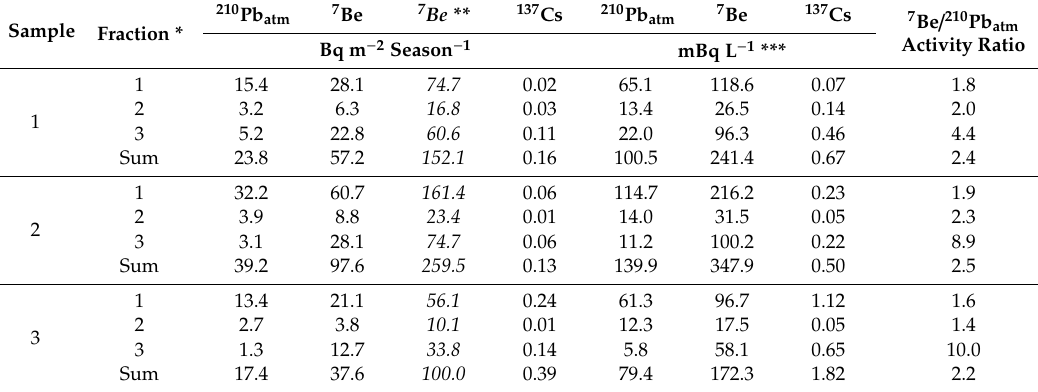
Table 2. Seasonal deposition fluxes and specific activities of the studied radionuclides in the snow